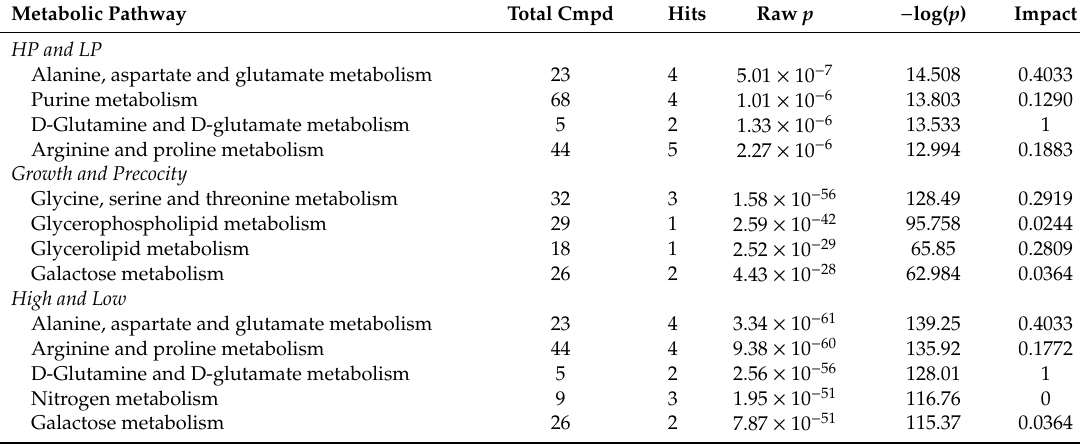
Table 2. Results from the polar meat extract pathway analysis from comparisons between HP and LP, Growth and Precocity (regardless the intensity of selection) and High and Low (regardless of selection